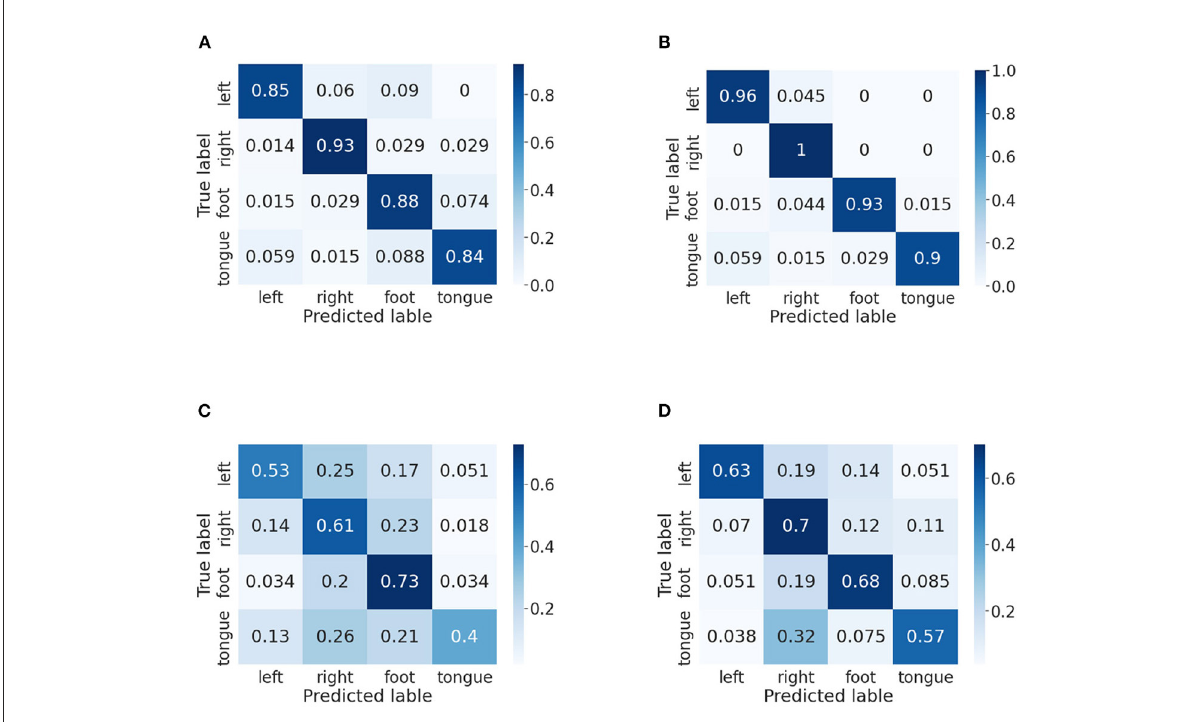
FIGURE5 Confusion matrices of BCI competition IV-2a datasets. (A) A03 without our method. (B) A03 with our method. (C) A04 without our method. (D) A04 with our method.